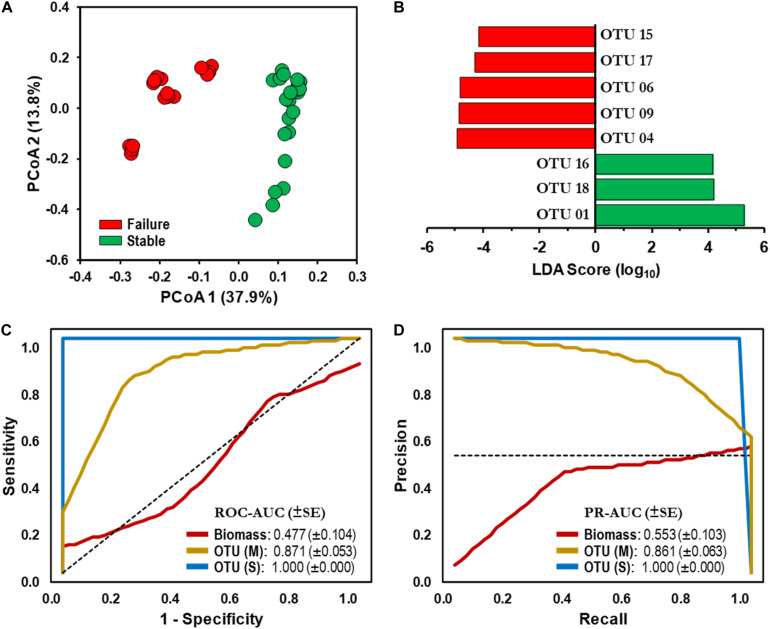
Microbial assemblages and bioindicator discovery. (A) Principal coordinate analysis (PCoA) ordination plot based on Jensen–Shannon dissimilarity of 16S rRNA operational taxonomic unit (OTU)-level bacterial profiles (cutoff = 0.03). Values in parenthesis indicate the percentage of total variation explained by the first two axes. Samples: Stable (SS, ), Failure (SF, ). (B) Identification of statistically significant genus-level assigned OTU bioindicators using linear discriminative analysis (LDA) effect size (LEfSe) analyses (LDA score > 4.0, p < 0.0001). Negative LDA scores are enriched in SF while positive LDA scores are enriched in SS events. (C) Receiver operating characteristic (ROC) and (D) Precision-recall (PR) curves with area under the curve (AUC) values and 95% confidence intervals in parenthesis for predictive model comparing biomass (ATP, ) and microbial bioindicators based on community membership [OTU (M), ] and structure OTU (S), ] data. Dashed lines indicate the null model. Samples: biomass, n = 32; OTU, n = 48.